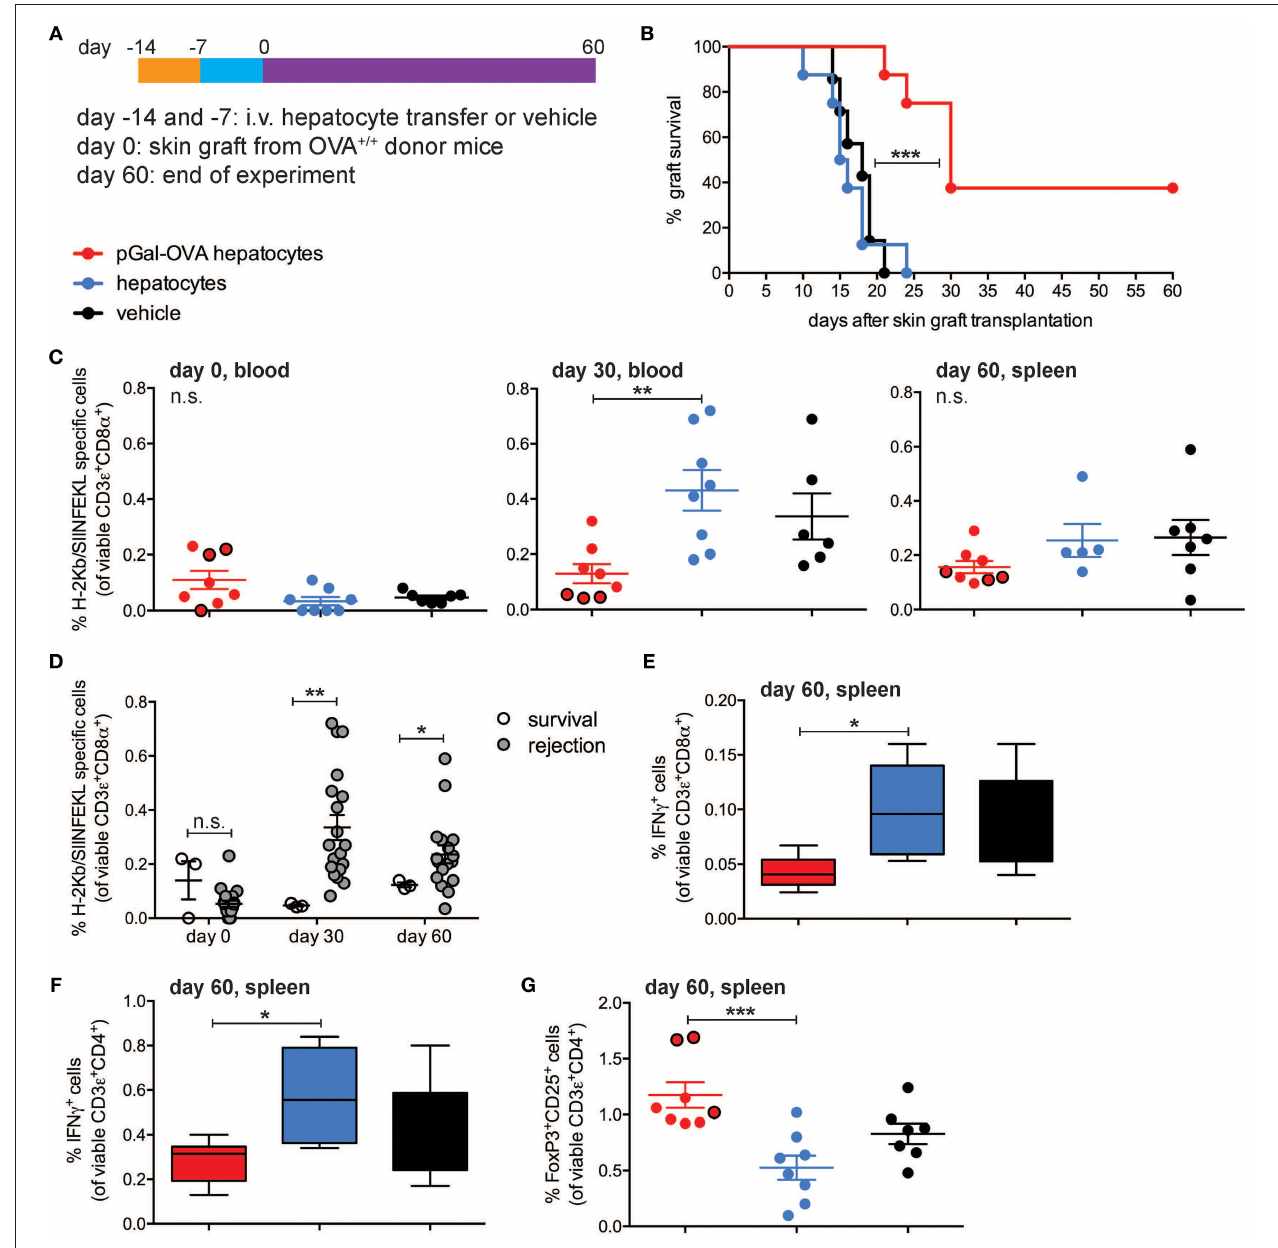
FIGURE 6 | OVA-specific hepatocyte-dependent cross-tolerance prevents acute rejection of skin grafts from OVA + mice. (A) Experimental design, in which hepatocytes are exposed to antigen ex vivo , prior to intravenous infusion. (B) Survival of the skin from a transgenic mouse expressing transmembrane OVA (OVA + skin) grafted onto wt C57BL/6 mice pre-treated with either pGal-OVA-incubated hepatocytes, untreated hepatocytes or vehicle according to the schedule indicated in (A) . (C) The frequency of endogenous H-2Kb/SIINFEKL-specific CD3 ε + CD8 α + cells in the blood or spleen of OVA + skin graft recipient mice on day 0 before transplantation (left), day 30 (middle), and day 60 (right) after transplantation was measured by flow cytometry. Dots outlined in black represent mice that retained skin grafts until day 60. (D) Frequency of endogenous H-2Kb/SIINFEKL-specific CD3 ε + CD8 α + splenocytes in mice retaining or rejecting the OVA + skin graft as detected by flow cytometry on day 0 (before grafting) and on day 30 in the blood and day 60 in the spleen. (E) Viable CD3 ε + CD8 α + splenocytes were analyzed by flow cytometry after harvesting on day 60 from skin-grafted C57BL/6 mice, ex vivo restimulation with OVA257-264 (SIINFEKL) and intracellular staining for IFN- γ . (F) Viable CD3 ε + CD4 + splenocytes were analyzed by flow cytometry after harvesting on day 60 from skin-grafted C57BL/6 mice, ex vivo restimulation with OVA 323 − 339 (ISQAVHAAHAEINEAGR) and intracellular staining for IFN- γ . (G) The frequency of viable FoxP3 + CD25 + CD4 + T cells was measured by flow cytometric analysis of splenocytes harvested on day 60 from skin-grafted C57BL/6 mice and restimulated with OVA 323 − 339 . Dots outlined in black represent mice that retained skin grafts until day 60. *** P < 0.001 in (B) (Log-rank Mantel-Cox test). * P < 0.05, ** P < 0.01, *** P < 0.001 and n.s., not significant in (C,E–G) (one-way ANOVA and Bonferroni post-hoc test correction). * P < 0.05, ** P < 0.01 and n.s., not significant in (D) (Mann-Whitney test). Data are representative of one experiment ( n = 8; mean and s.e.m. in C–G